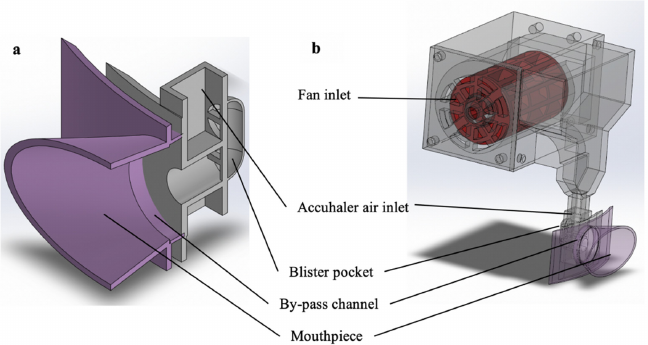
Figure 3. CAD modelling of ( a ) the Accuhaler and ( b ) Accuhaler with add-on device.